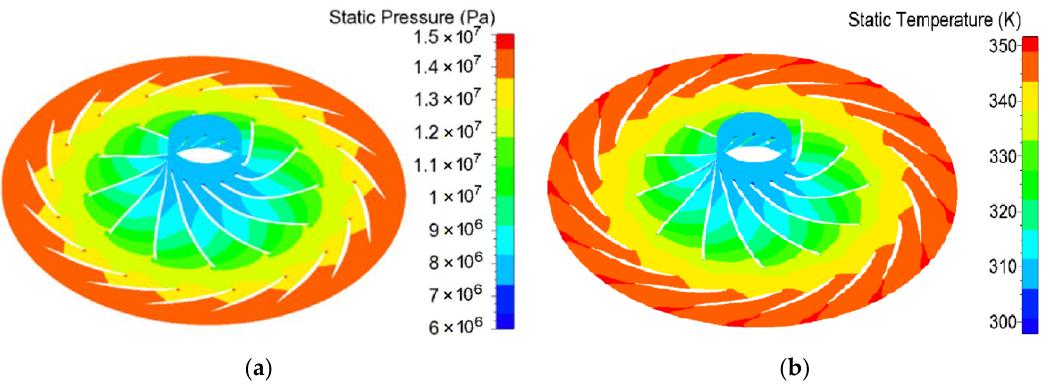
Figure 15. The pressure and temperature distribution of the 50% blade height section for the optimal